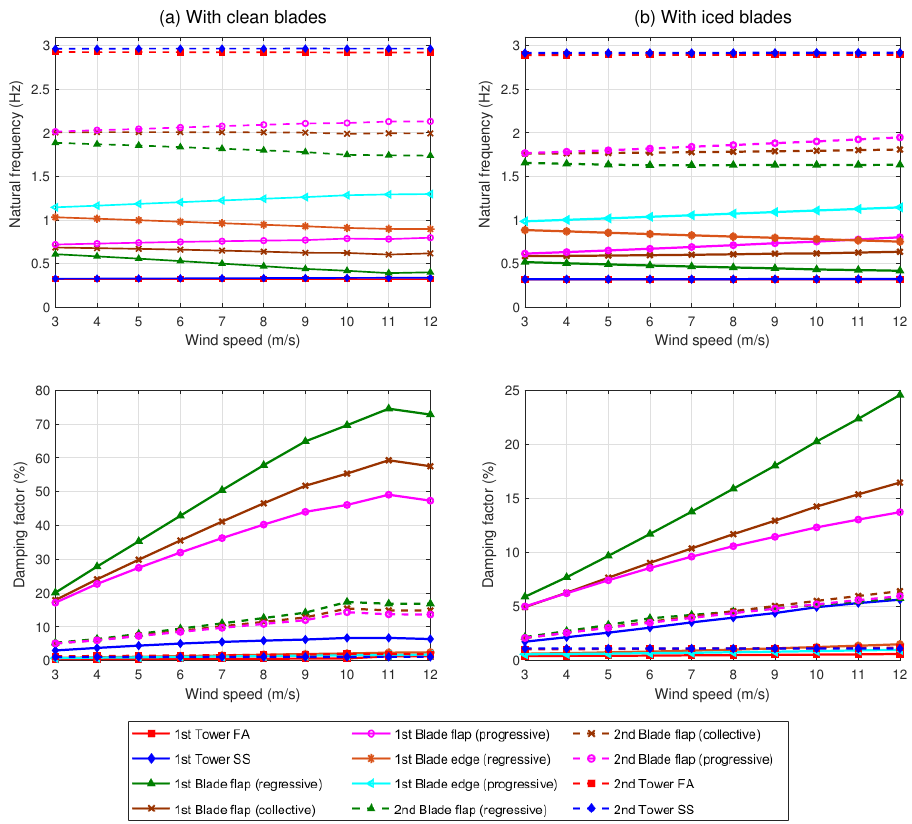
Figure 15. Influence of icing on the modal behavior (aeroelastic natural frequencies and damping factors) of the NREL 5 MW wind turbine blade. The Y-axis scale for the damping factor graphs is